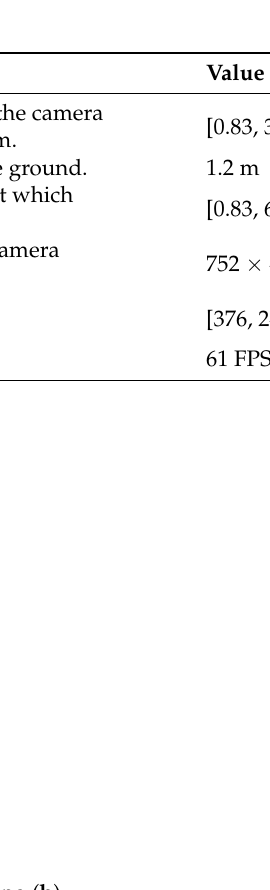
Figure 3. CMOS FireFly MV camera ( a ) and camera vehicle mounting ( b